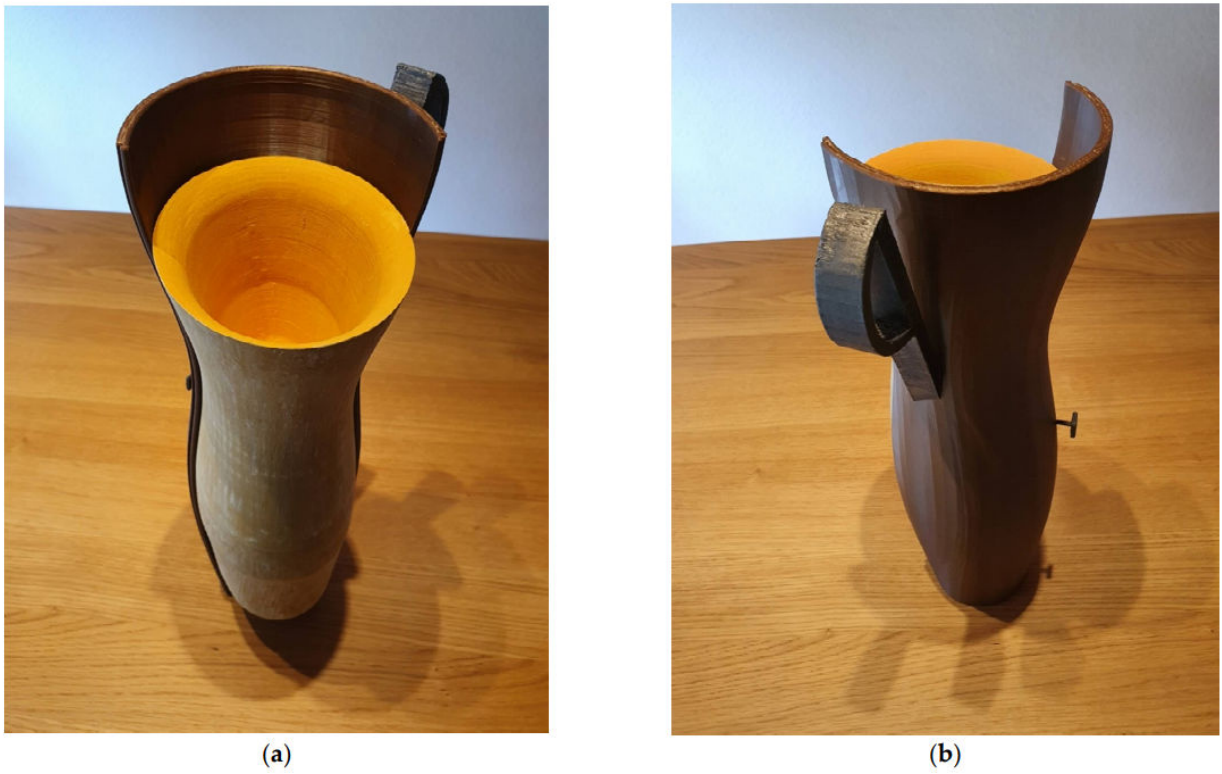
Figure 5. 3D print of the reconstructed Capua leg, wooden core and one half of the sheathing: ( a ) View from inside out; ( b ) View from outside